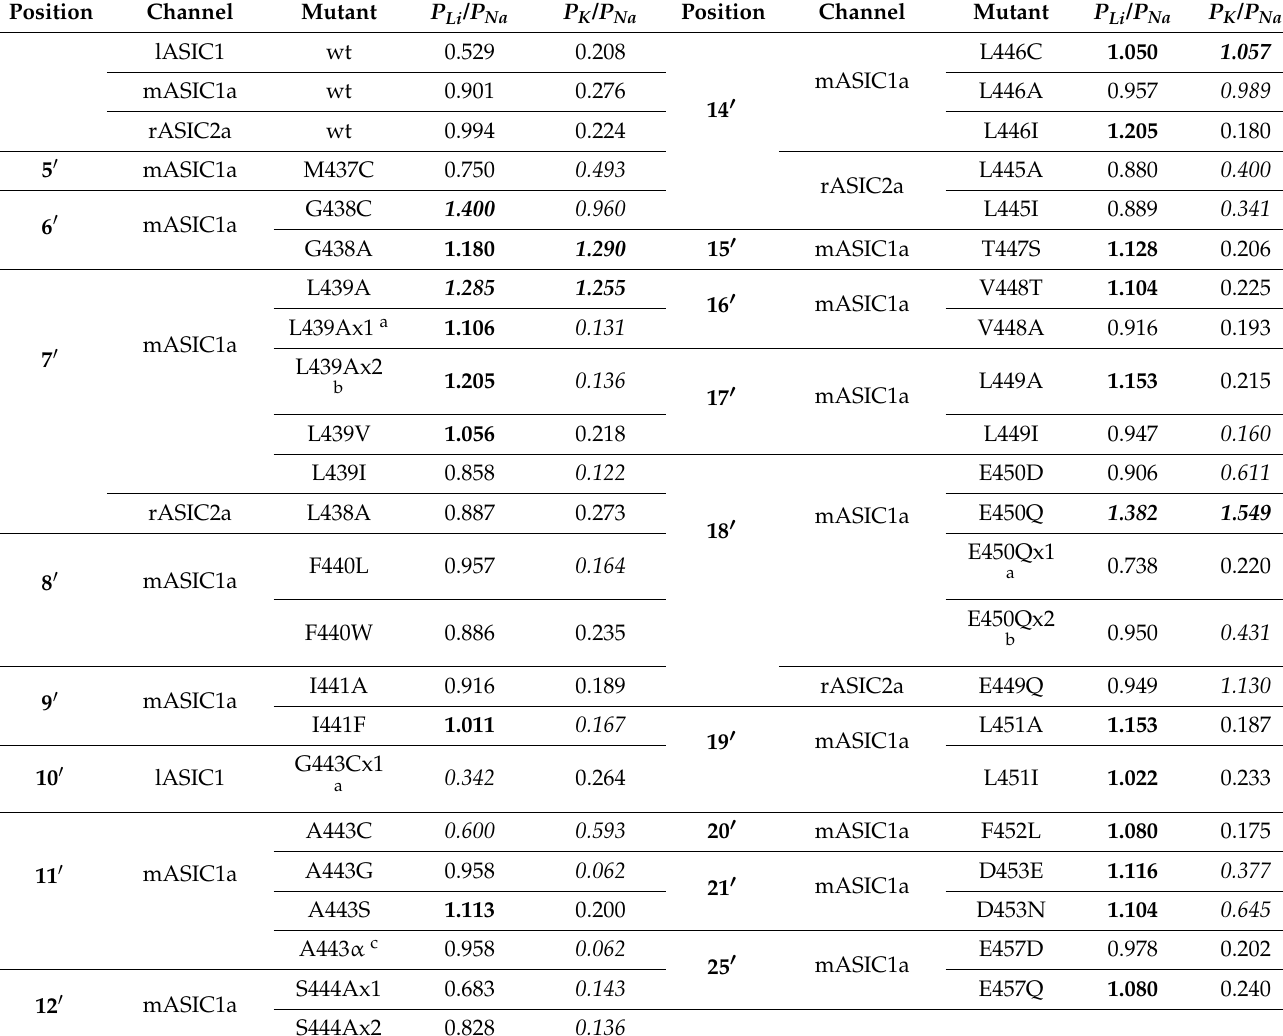
Table 4. Permeability ratios of tested ion over Na + for ASIC single mutations variants . Ratios that are different from wild type by ± 30% are represented in italic (considered as “significant”) and ratios that describe change in ion selectivity are represented in bold.